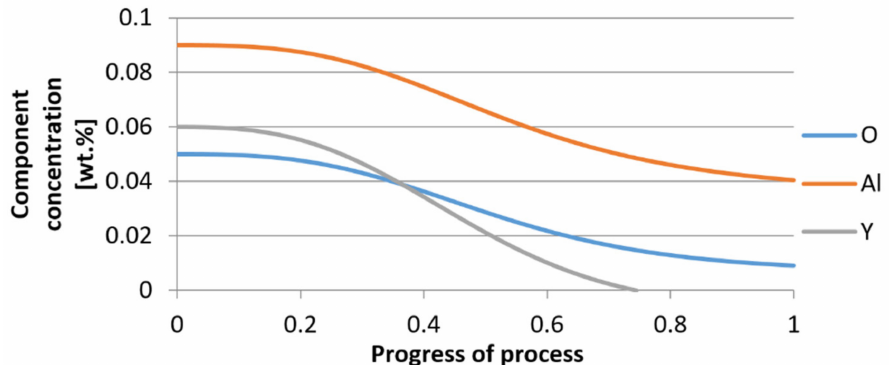
Figure 22. Change in component concentration during bi-component nucleus growth (Al 2 O 3 –Y 2 O 3 ) in steel 2 (for r 0 = 1 µ m).